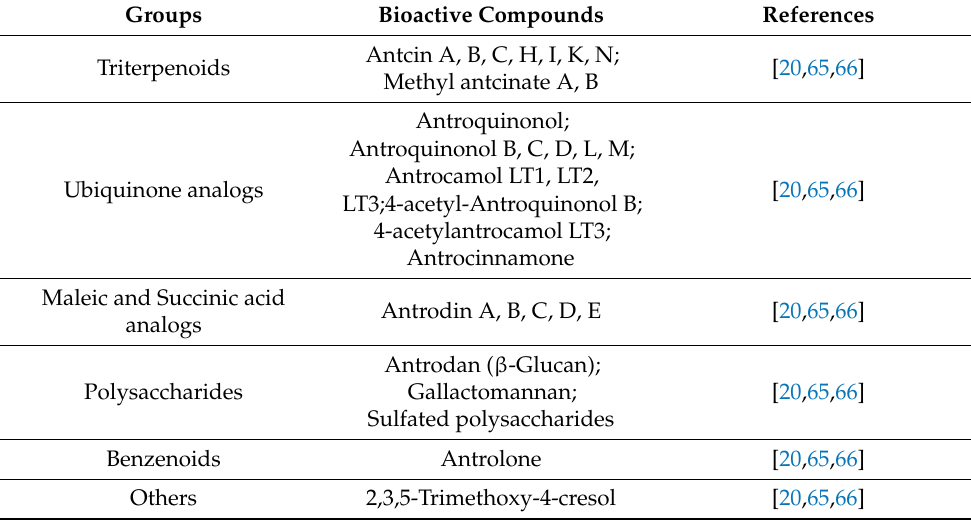
Table 4. Exemplary chemical compounds identified in T. camphoratus . Groups Bioactive